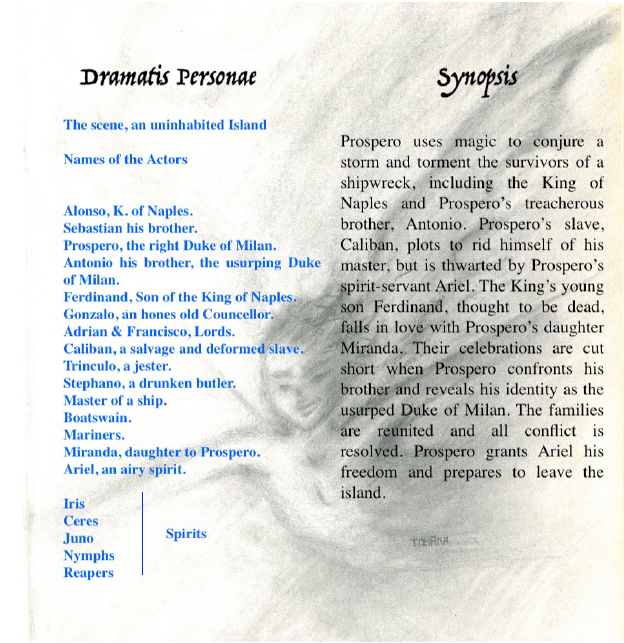
Figure 3. Dramatis personae from Shakespeare (1986). Syn- opsis source: https://www.shakespeare.org.uk/ (last access: 3 March 2021). In the background, Ariel, drawn by the author, can be